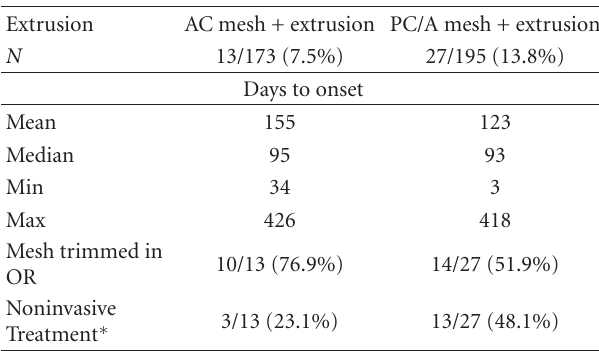
Table 2: Extrusion incidence and treatment.